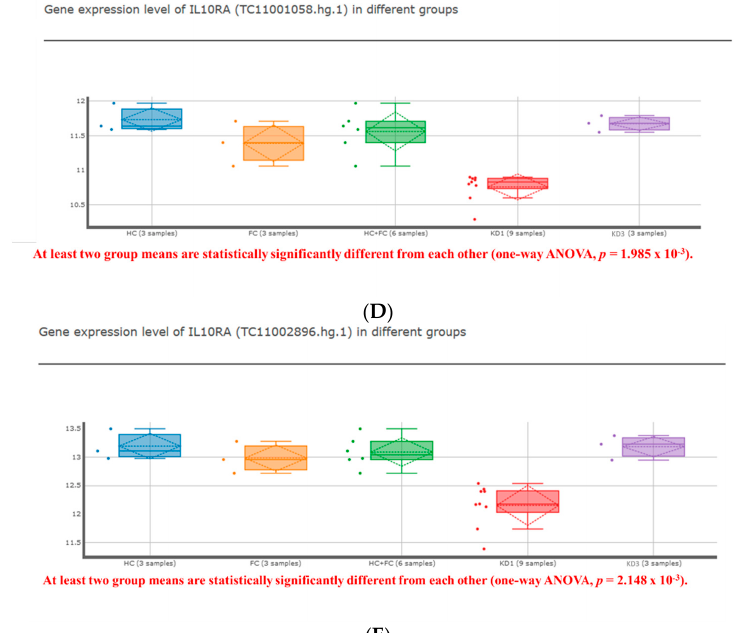
Figure 1. Expression analysis of ( A , B ) SELL , ( C ) SERPINB1, and ( D , E ). IL10RA in leukocytes assessed using KDmarkers tool. The representative gene SELL of lung-resident eosinophils was significantly higher in Kawasaki disease. ANOVA, analyses of variance; FC, febrile control; HC, non-febrile control; KD1, pre-IVIG (intravenous immunoglobulin) patients with Kawasaki disease (KD); KD3, KD patients three weeks after IVIG. IVIG, intravenous immunoglobulin; KD, Kawasaki disease.